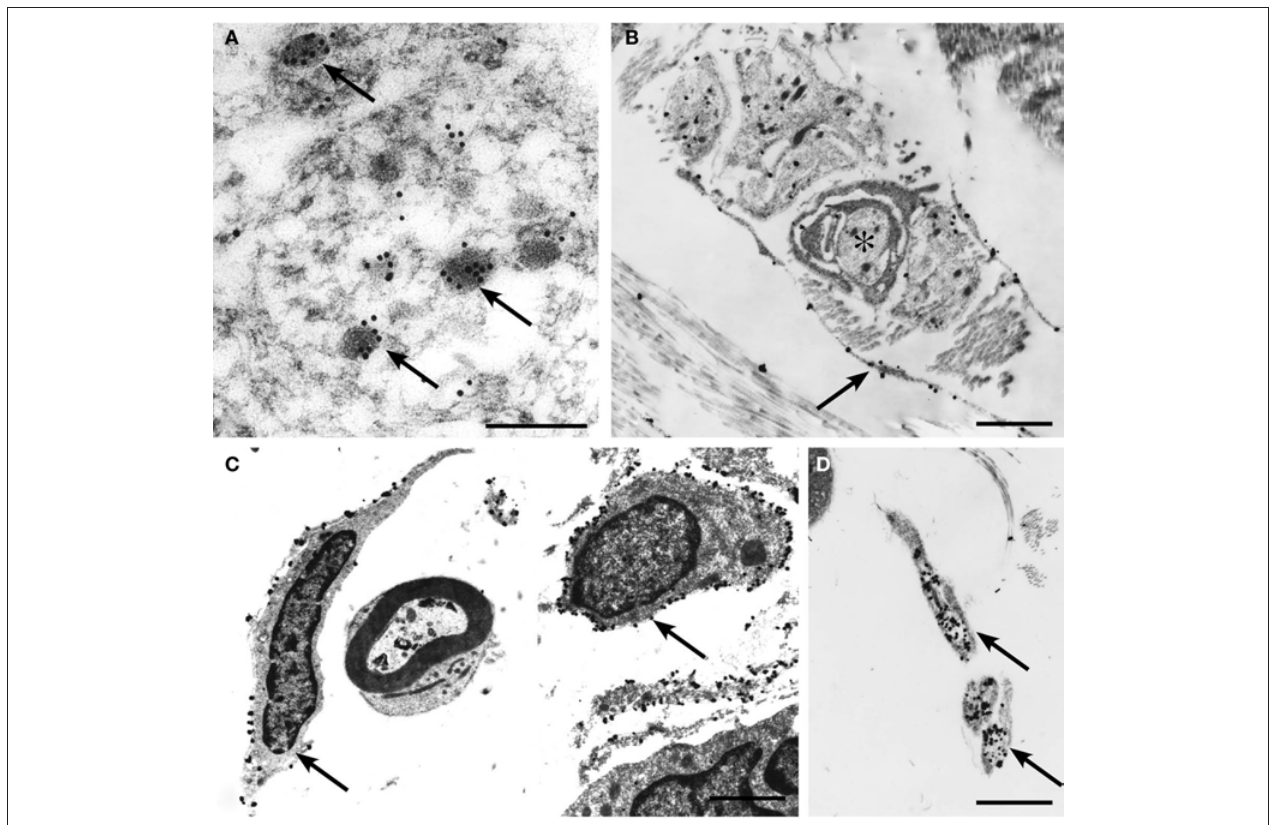
Figure 5 | electron micrographs showing immunogold-labeled sections. (A) Unmyelinated axon profiles in the vicinity of the CNS–PNS border in a specimen (180-days survival) embedded in LR White. A number of dense cored vesicles labeled with SP antibodies and secondary antibodies conjugated with 10-nm gold particles (Scale bar = 0.25 μm). The gold particles seem to be preferentially associated to dense cored vesicles. (B,C) Electron micrographs from a specimen incubated with p75 antibodies. After incubation with gold-conjugated secondary antibodies and silver enhancement a strong labeling of unmyelinated axons is observed in juxtamedullary ventral root fascicles